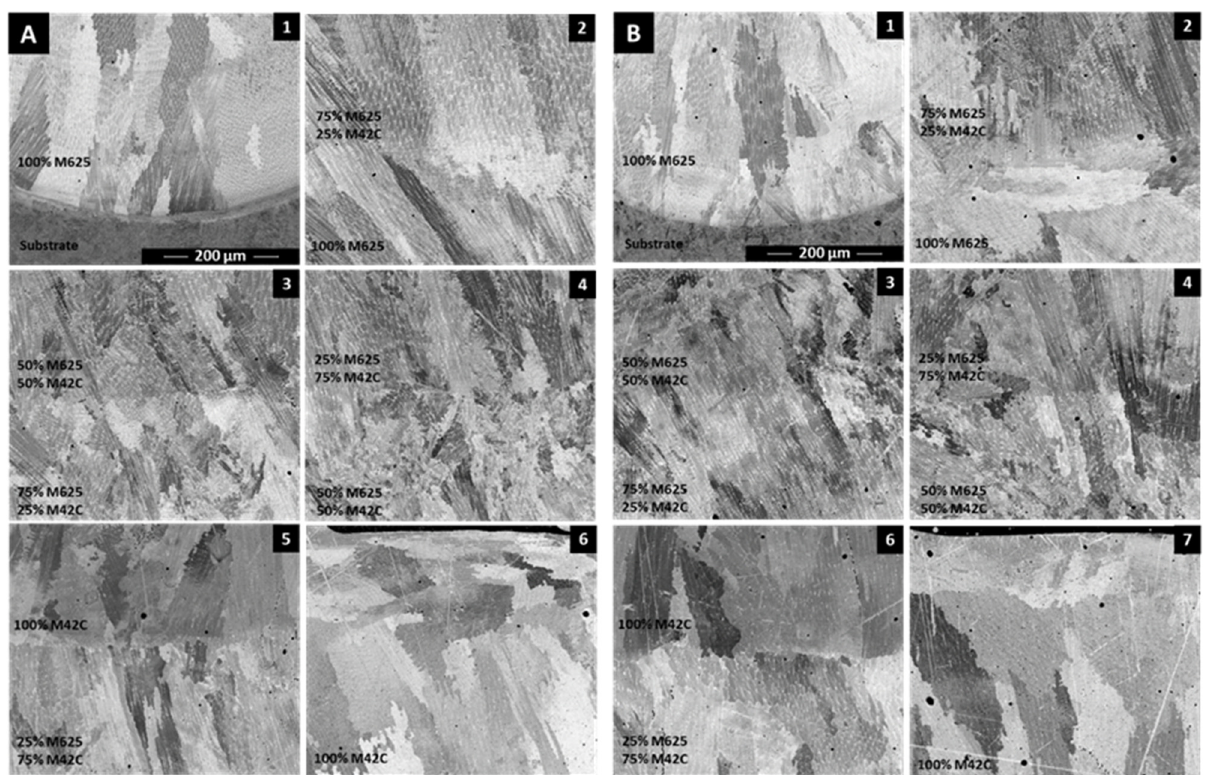
Figure 4. Microstructural evolution in the transversal cross-section of FGMs produced ( A ) without and ( B ) with the application of PHT (SEM/BSE images).